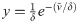
The network of pairwise interactions and the flow of food over interactions.(a) Visualization of the undirected trophallactic network (Colony A). Ants are represented by vertices and interactions are edges using the spring embedded layout from Networkx [37]. Nodes are colored according to maximally modular communities which, nevertheless, display low modularity with 191 intra-community and 223 inter-community links (Details: Number of communities = 5, transitivity = 0.38, modularity = 0.185, quality performance = 0.76). For colonies B and C, see S3 Fig. (b) Probability density as a function of the transfer ratio. Different colors relate to the maximal potential interaction p = d(1 − r) where p ∈ [0, 1] is the volume potential as determined by d, r ∈ [0, 1] donor’s and recipient’s crop load expressed as a fraction of the capacity of each ant. The distribution of interaction volumes per each transfer potential, p, were estimated by exponential functions y=1δe-(v˜/δ) in which the values of the parameter δ were determined using maximal likelihood. These values of δ all produce decent fits (R2 values are indicated in figure legend) and are, largely, independent of the maximal transfer potential. This implies that the ants control the fraction of volume transferred (out of the maximal possible interaction volume) rather than absolute amounts. Data depict interactions from all three experiments (N = 2141 interactions).